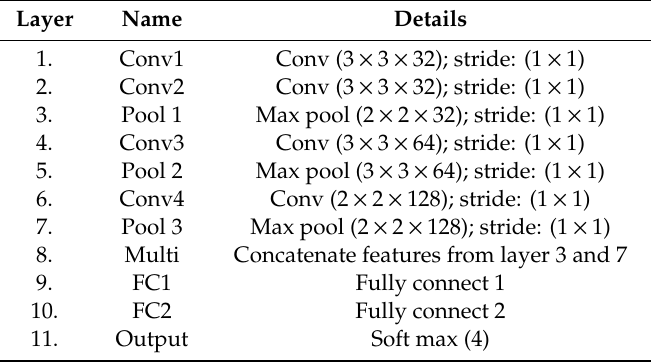
Table 1. Multi-scale CNN configuration.